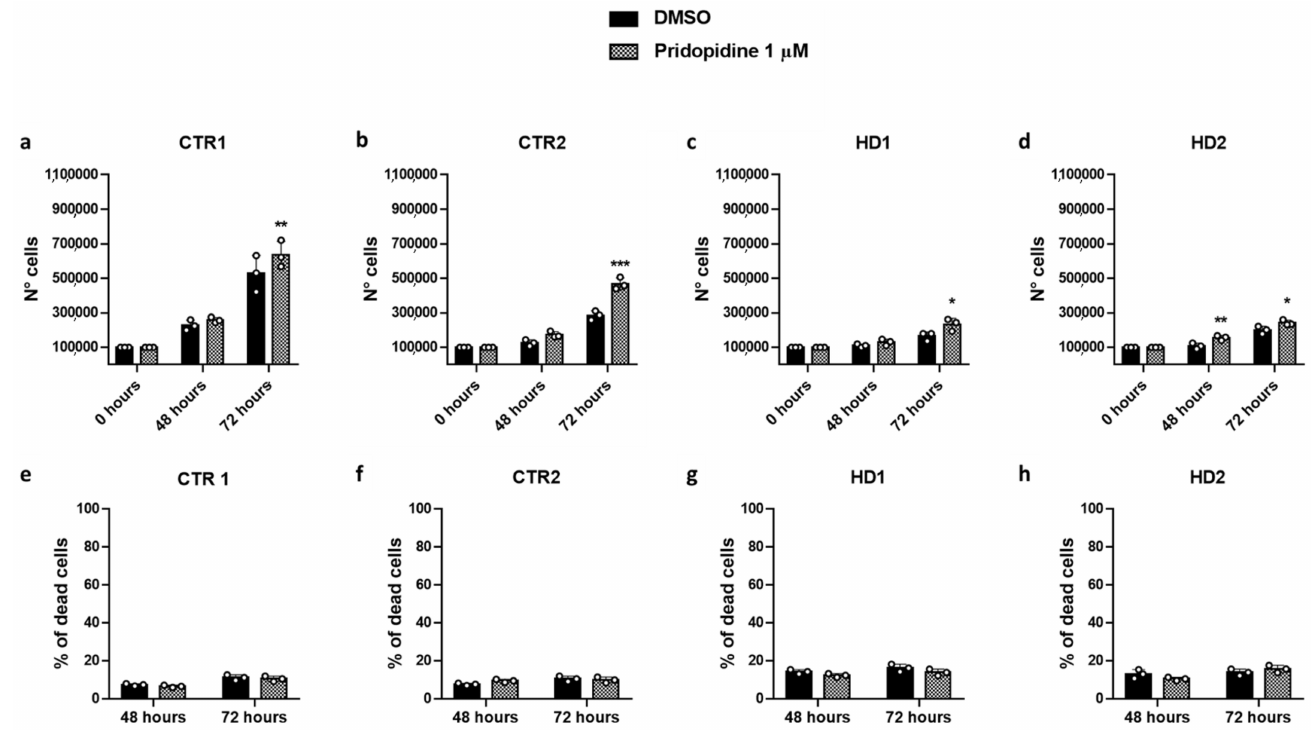
Figure 6. Pridopidine effect on CTR1 ( a ), CTR2 ( b ), HD1 ( c ) and HD2 ( d ) cell growth, and CTR1 ( e ), CTR2 ( f ), HD1 ( g ) and HD2 ( h ) percentage of dead cells. Fibroblast numbers were determined by direct counting of st0ained and unstained cells after 48 and 72 h and plotted against culture time. Data are shown as mean ± SD. * p < 0.05, ** p < 0.01, *** p < 0.0001, compared with DMSO treatment (Two-way ANOVA, followed by uncorrected Fisher’s LSD for multiple